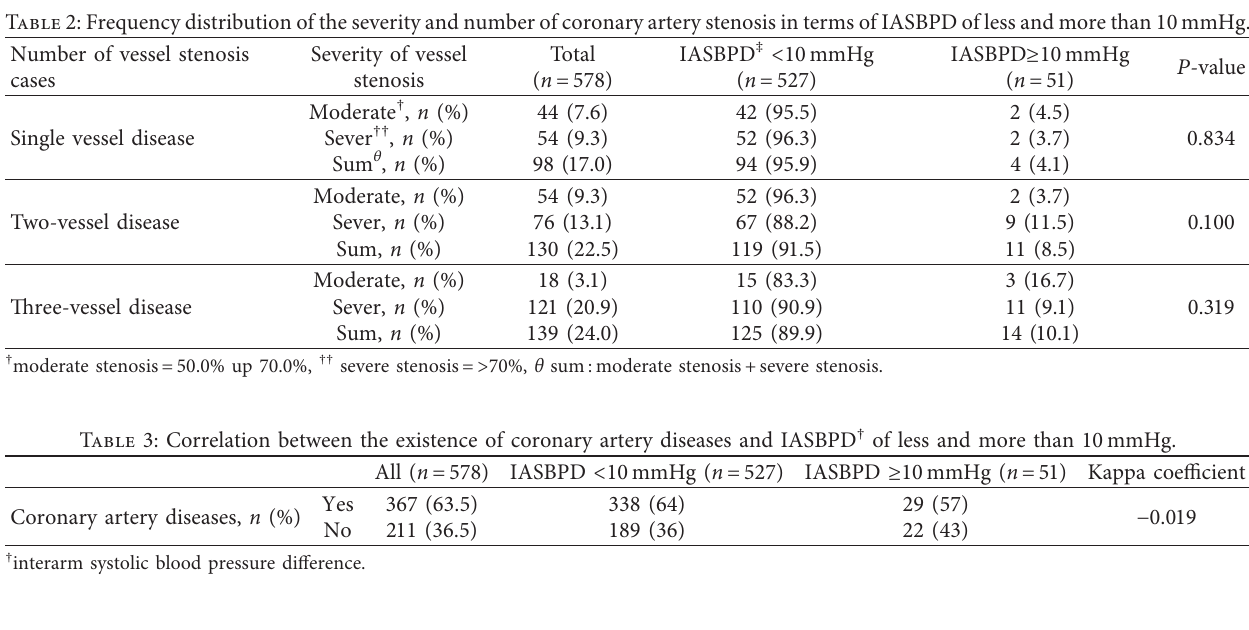
Table 2: Frequency distribution of the severity and number of coronary artery stenosis in terms of IASBPD of less and more than 10mmHg. Number of vessel stenosis cases